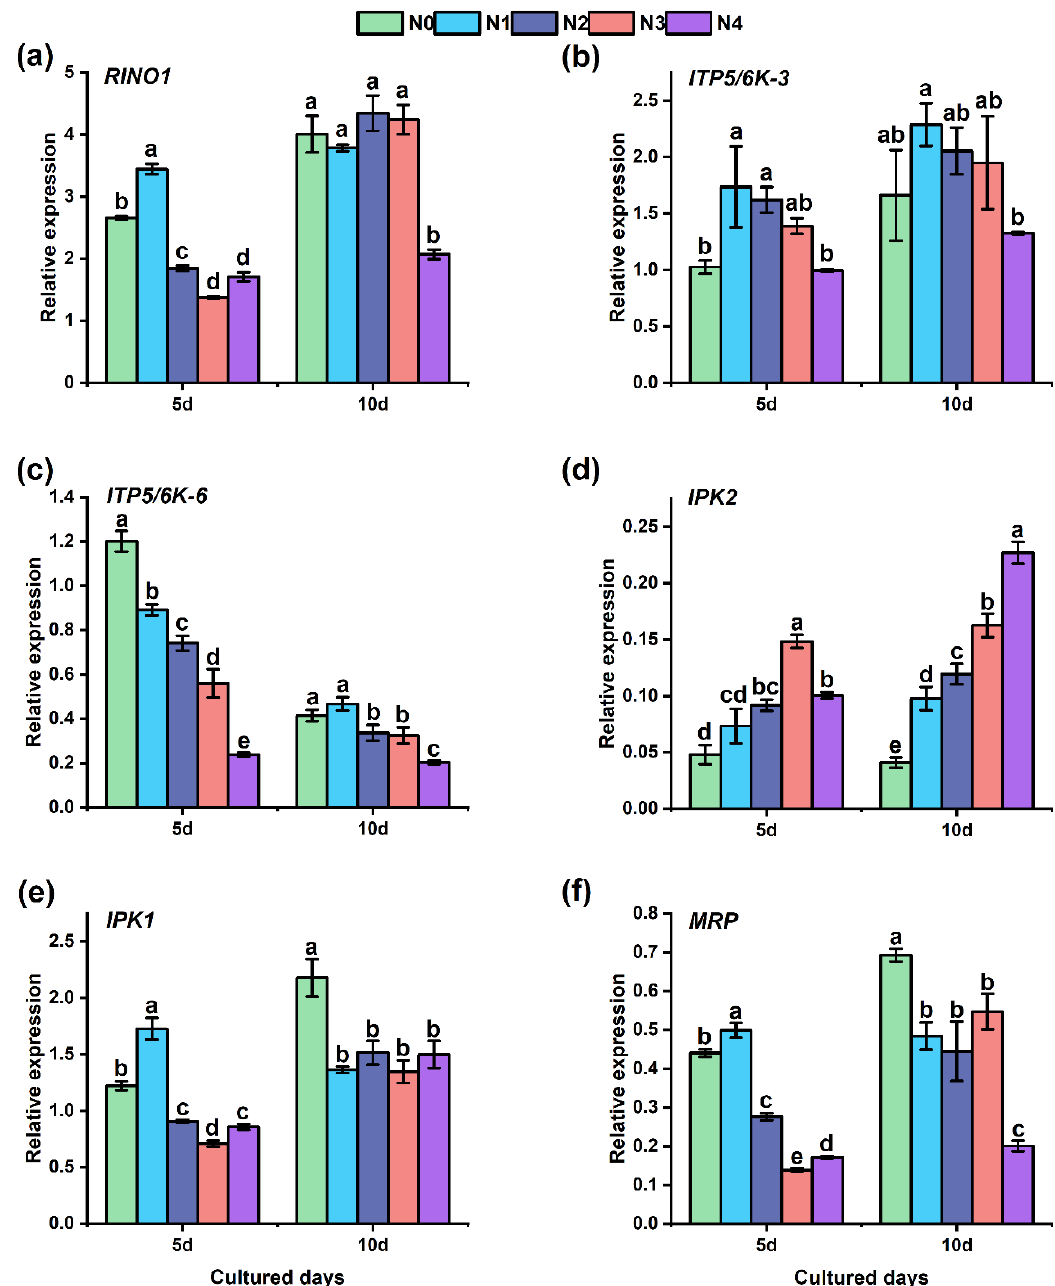
Figure 4. N-induced phytic acid (PA) synthesis-related genes expression in the grains; ( a ) RINO1 , ( b ) ITP5/6K-3 , ( c ) ITP5/6K-6 , ( d ) IPK2 , ( e ) IPK1 , ( f ) MRP under detached panicle culture for XS110. Bars indicate the mean ± SE. Different letters for every five N levels denoted significant difference according to one-way ANOVA analysis followed by Tukey’s multiple comparison test.